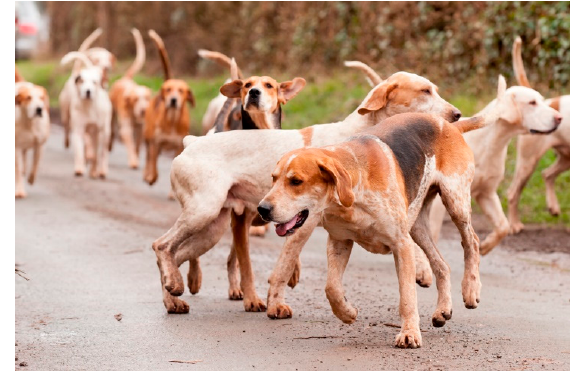
Figure 2. Source: Shutterstock 174654926.